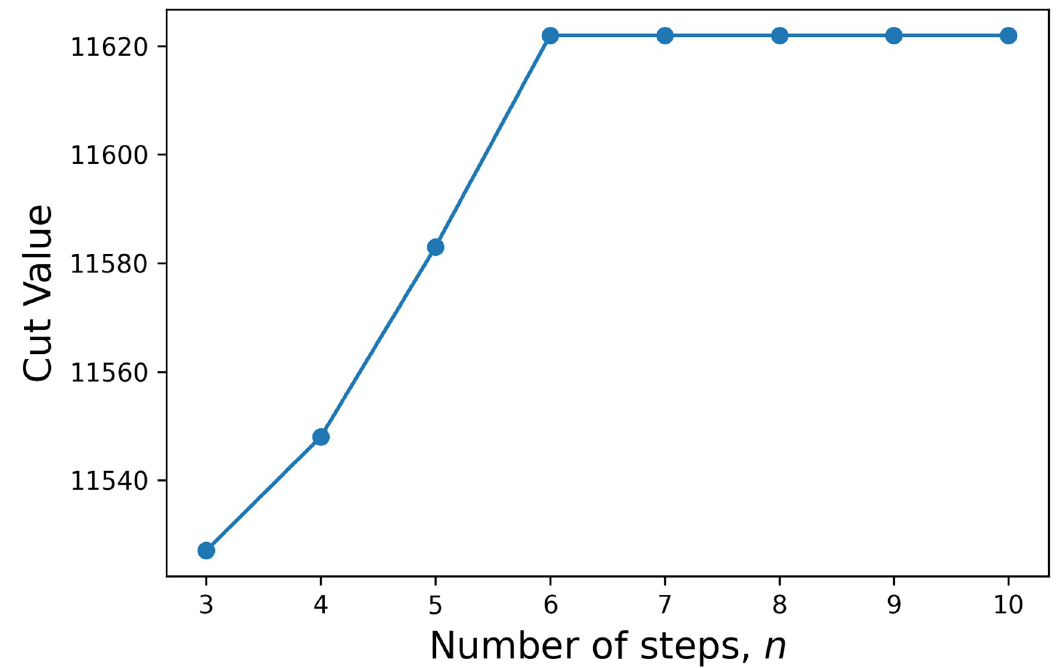
Fig 3. Convergence of the Cut Value of QFMA as a function of steps for the G1 problem.